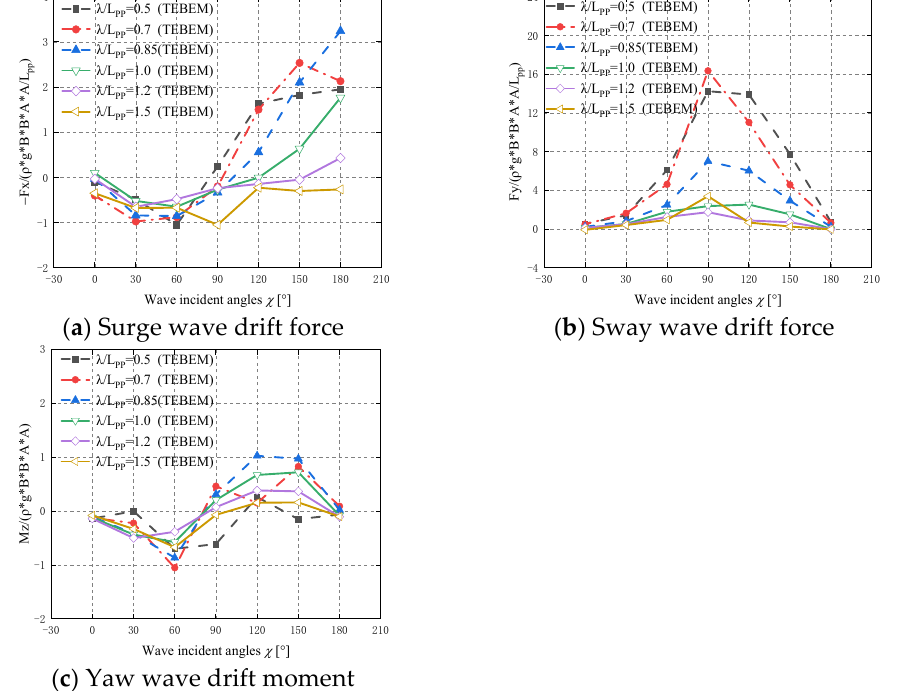
Figure 18. The surge, sway, and yaw wave drift forces and moment of KVLCC2 with H = 0.02 L PP , χ = 0°, 30°, 60°, 90°,120°,150°, 180°, β = 18.4°, and U = 6.0 kn.